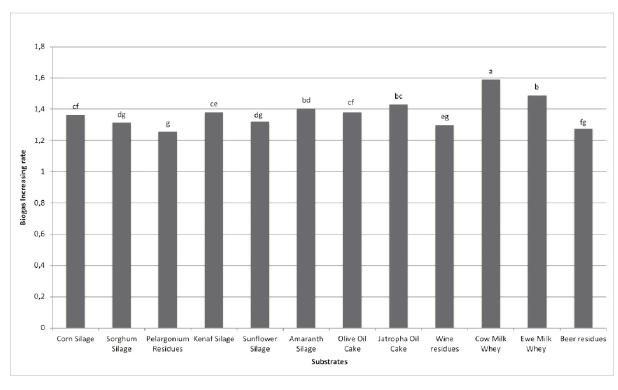
Fig. 3 - IBR values for different substrates. Different letters t(2-8) means significative differences between substrates according to Bonferroni Multiple Comparisons Test (P<0.05).